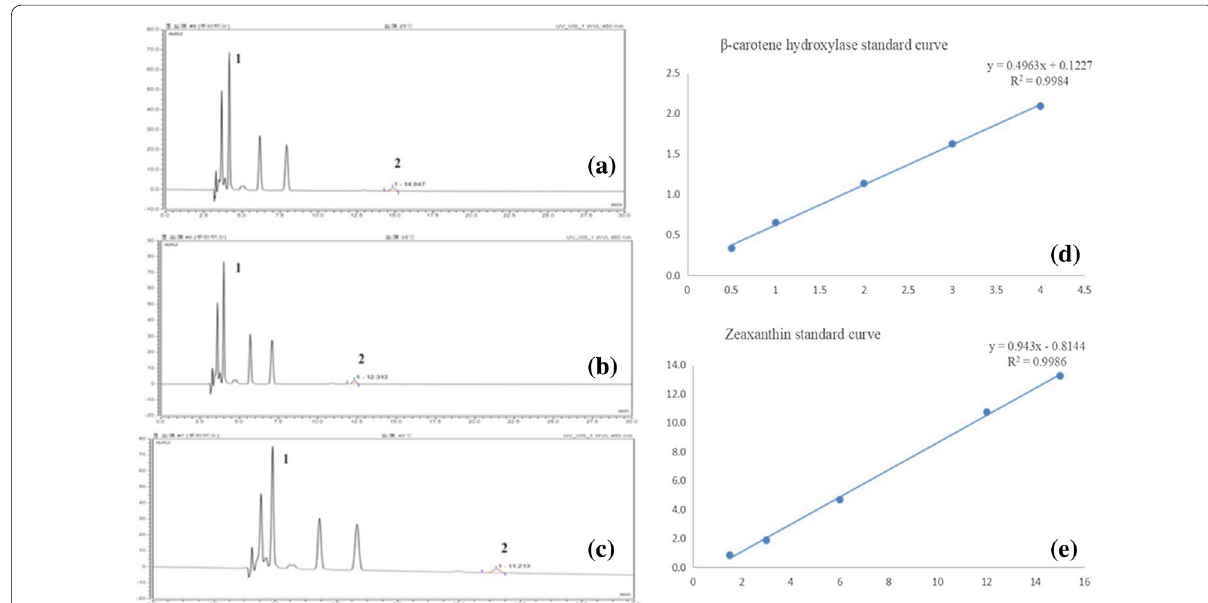
Fig. 6 HPLC with diode-array detection and retention times of D. salina extracts at different temperatures. a HPLC chromatograms of WT D. salina extracts at 25 ℃ (Peak 1: zeaxanthin; Peak 2: β-carotene). b HPLC chromatograms of WT D. salina extracts at 35 ℃ . c HPLC chromatograms of WT D. salina extracts at 40 ℃ . d Standard curve of β-carotene. e Standard curve of zeaxanthin